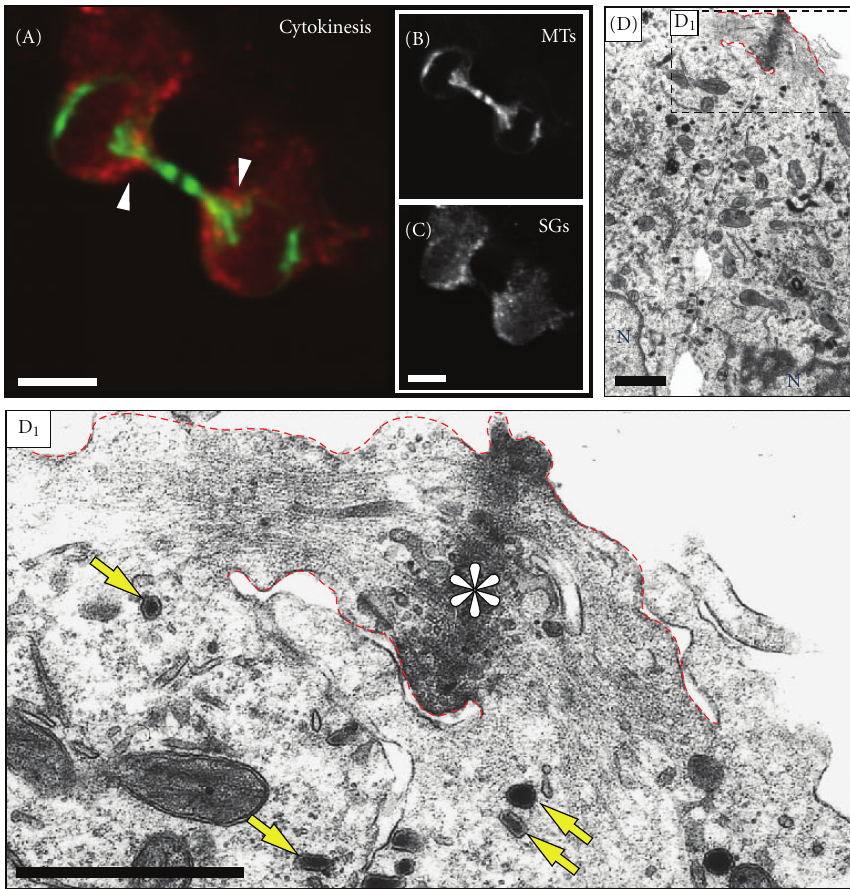
Figure 8: Distribution of SGs during cytokinesis. Single confocal images of immunostained PC12 cells in cytokinesis are shown as indicated. The main image (A) shows a merged presentation of microtubules and SGs; the single channels are shown in grayscale in (B) and (C), respectively. During cytokinesis, SGs were found to accumulate at the bases of the intercellular bridge ((A), arrowheads), but not in the midbody ((A) and (C)). ((D) and (D 1 )) PC12 cells in cytokinesis observed at the ultrastructural level. Shown in (D) are two PC12 daughter cells during cytokinesis which are connected by a midbody ((D), red dashed lines). The marked area (box in (D)) is magnified in (D 1 ). Note that SGs are found only at the base of the intercellular bridge ((D 1 ), yellow arrows). The asterisk in (D 1 ) indicates the microtubule overlap region of the midbody. N, nucleus. Scale bars, (A)–(D), 5 μ m, (D 1 ), 1 μ